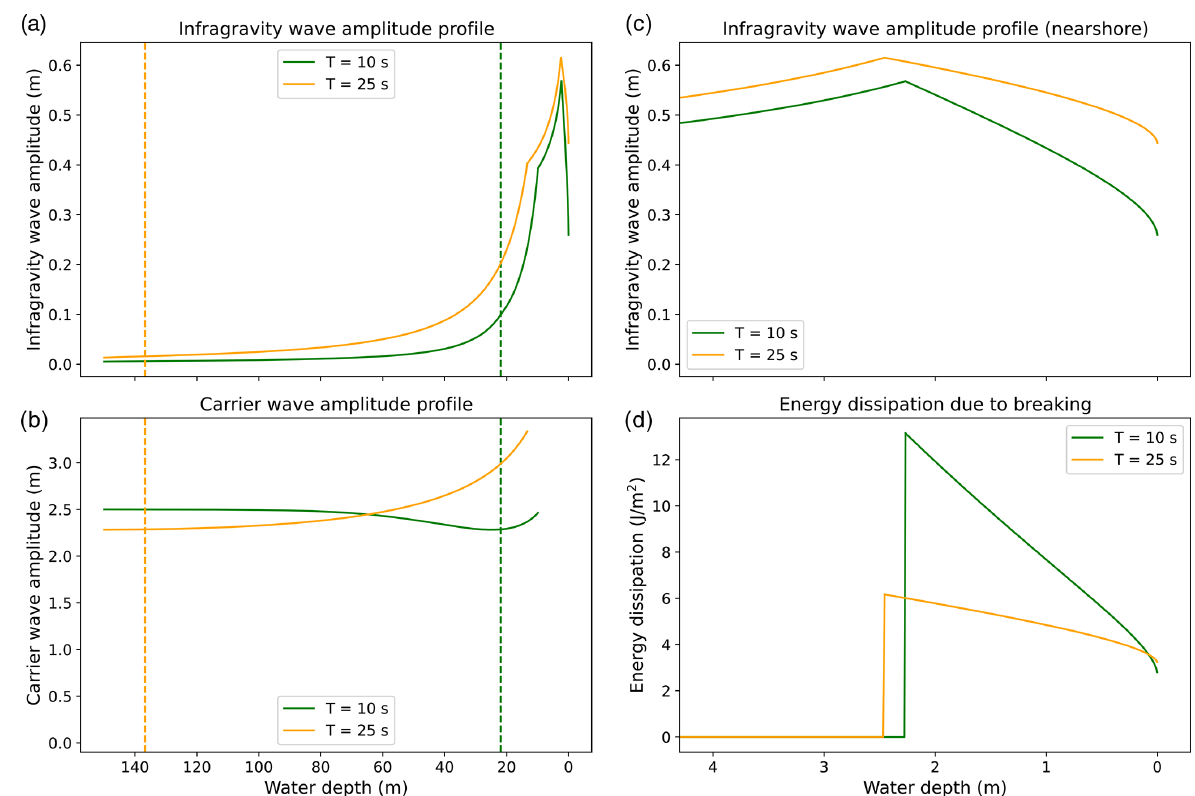
Figure 13. Infragravity (a, c) and carrier (b) wave amplitude profiles and energy dissipation rate (d) for 10s (green) and 25s (orange) carrier waves. Dashed lines indicate the locations where infragravity waves first enter the shoaling region. Infragravity amplitudes are computed with Eq. (2) seaward of the shoaling region, as ∝ h − α in the shoaling region up to the breakpoint of the carrier waves and as ∝ h − 1 / 4 from the carrier wave breakpoint to the infragravity wave breakpoint, and with Eq. (5) shoreward of the infragravity wave